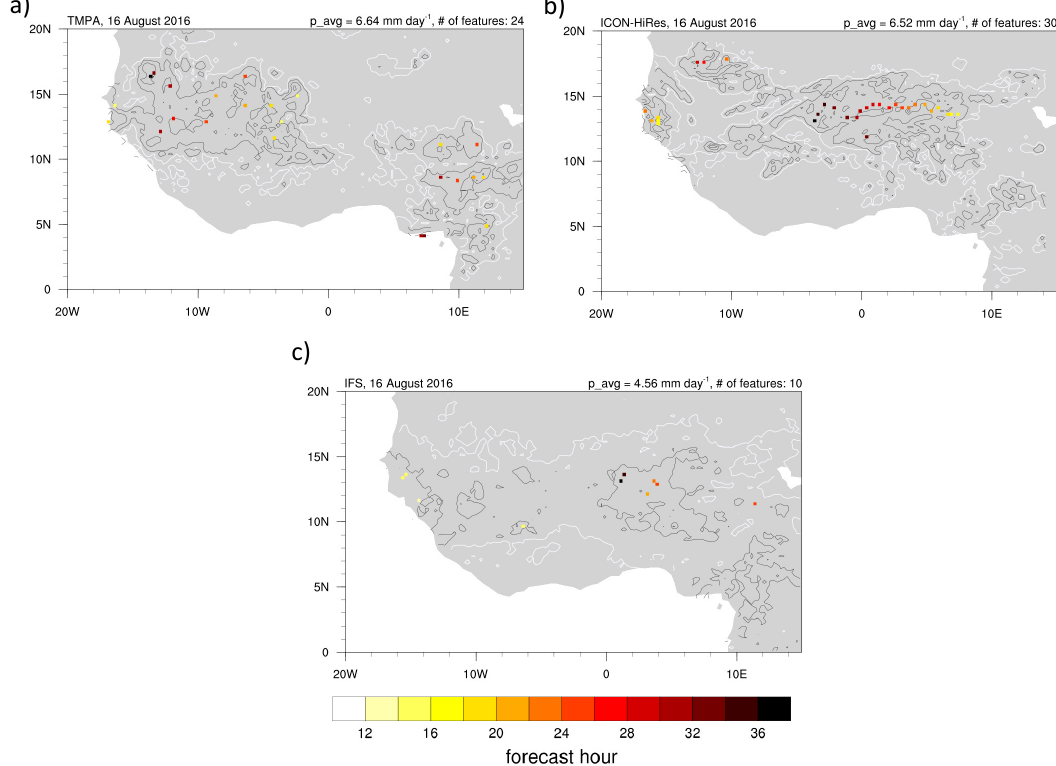
Figure 3. Objectively-identified precipitation features of 20 or more connected grid points with hourly rain rates exceeding a threshold of γ p ,2 D > 70 mm day − 1 sorted by forecast hour during which they were simulated (colors) and daily surface precipitation over land (contours) for 16 August 2016: ( a ) TMPA; ( b ) ICON-HiRes; and ( c ) IFS. The contour lines denote precipitation of 1, 10, 40, 80, and 120 mm day − 1 . The 1-mm day − 1 contour is shown in white. The average precipitation is shown at the top of each